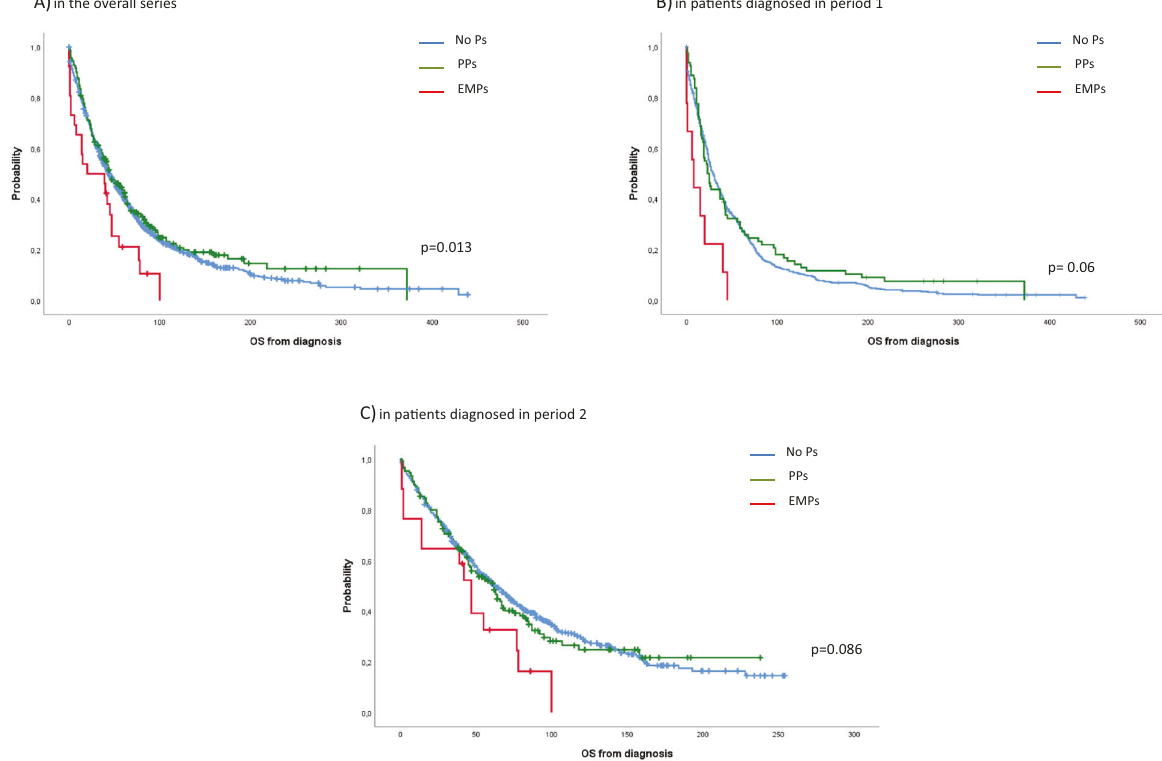
Fig. 1 Overall survival from diagnosis. A in the overall series, B in patients diagnosed in period 1, C in patients diagnosed in period 2.1.